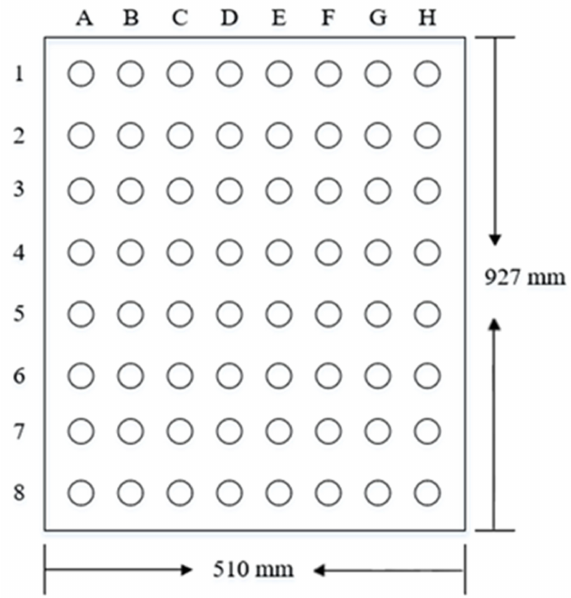
Figure 4. The sketch map of detection spots over the perforate